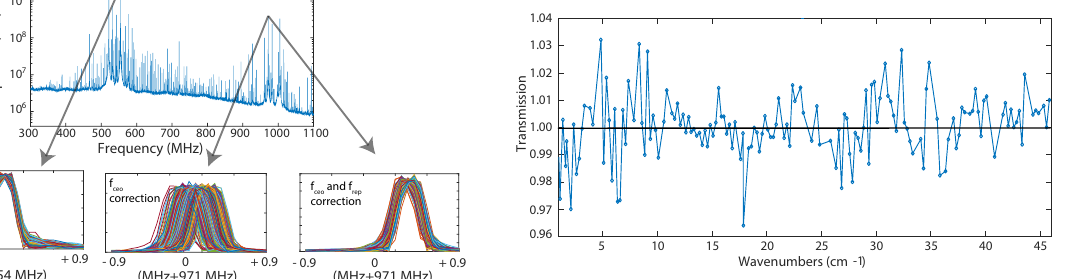
Figure 20: Digital adaptive sampling technique used to correct f ceo and f rep fluctuations. The improved algorithm corrects for both f ceo and f rep .